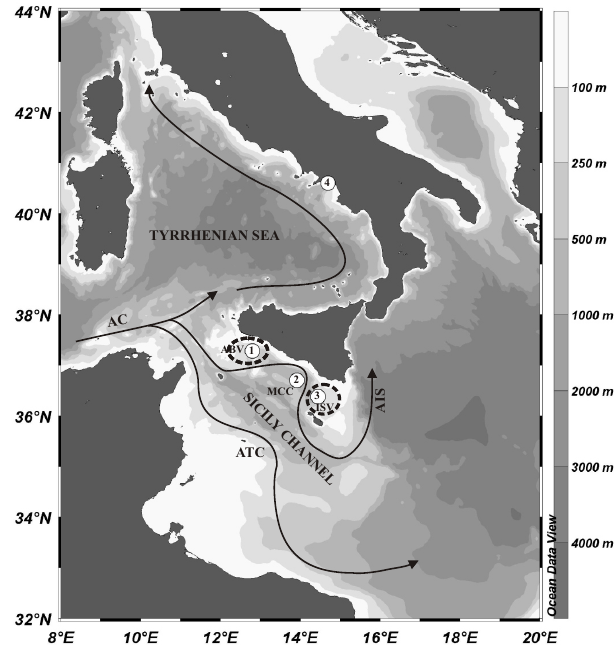
Fig. 1. Bathymetric map of the Mediterranean Sea and core loca- tions. Surface water circulation in winter is illustrated, with major currents and semi-permanent features: AC, Algerian Current; ATC, Atlantic Tunisian Current; AIS, Atlantic Ionian Stream; ABV, Ad- venture Bank Vortex; MCC, Maltese Crest Channel; ISV, Ionian Shelfbreak Vortex. Circles show: (1) St 272; (2) St 342; (3) St 407; (4)